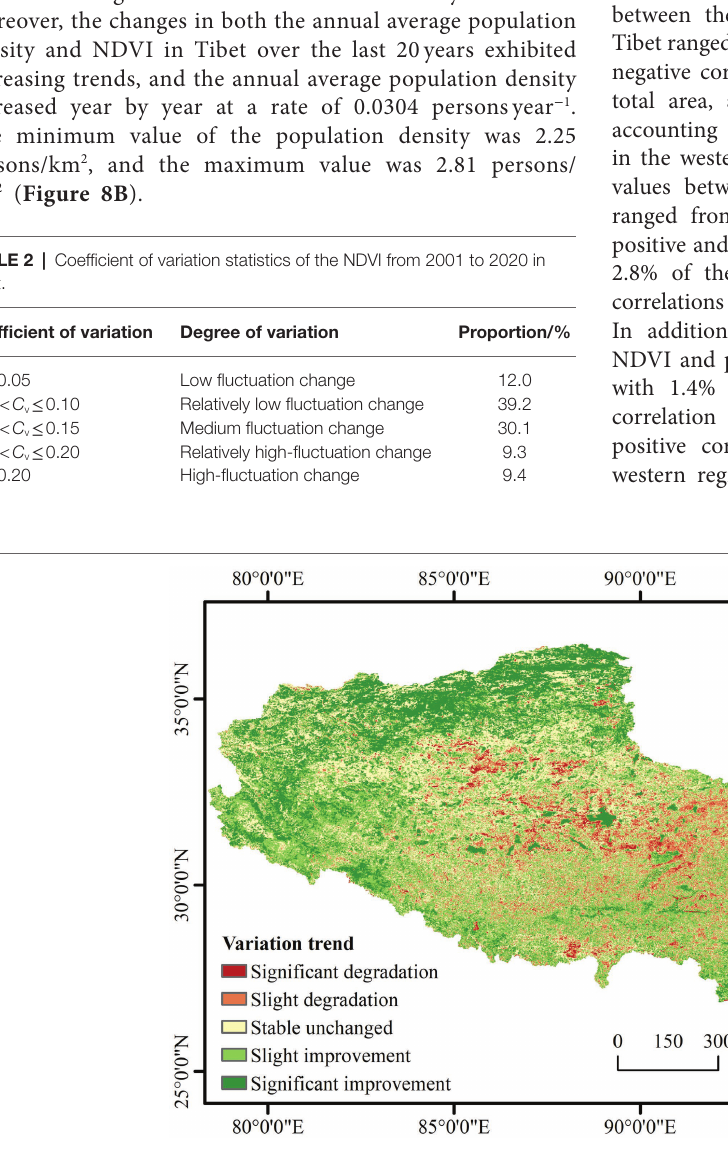
FIGURE 6 | Spatial pattern of the NDVI change trends from 2001 to 2020 in